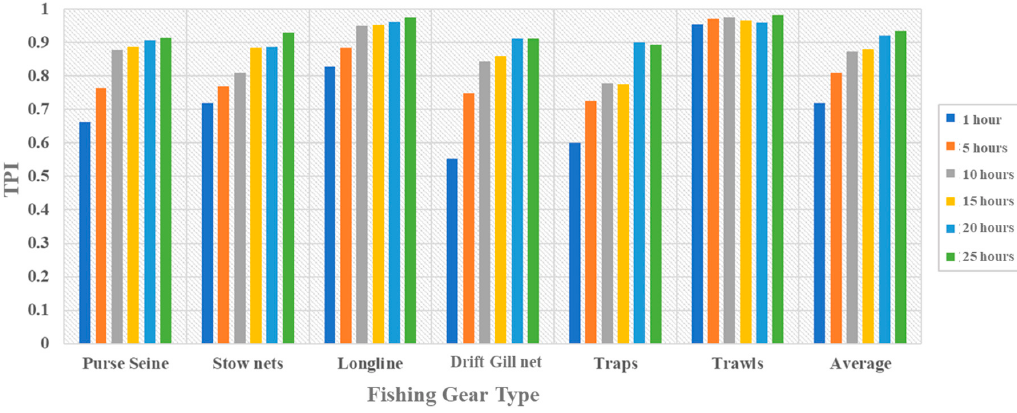
Figure 9. The trajectory window-wise performance index (TPI) performance changes with TW size.